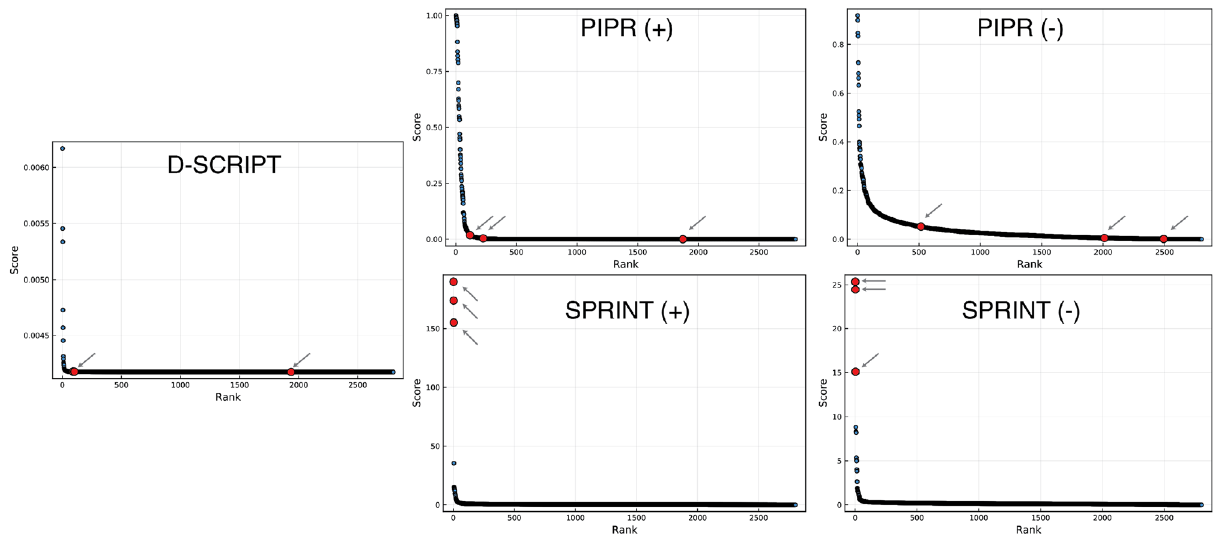
Figure 7. One-to-all curves for carperitide. The one-to-all curves generated using the predicted interaction scores of the three predictors are shown here. The true target protein is highlighted in red, while the black dots represent off-target proteins. One-to-all curves generated with predictors trained in the optimistic scenario are indicated with a (+).